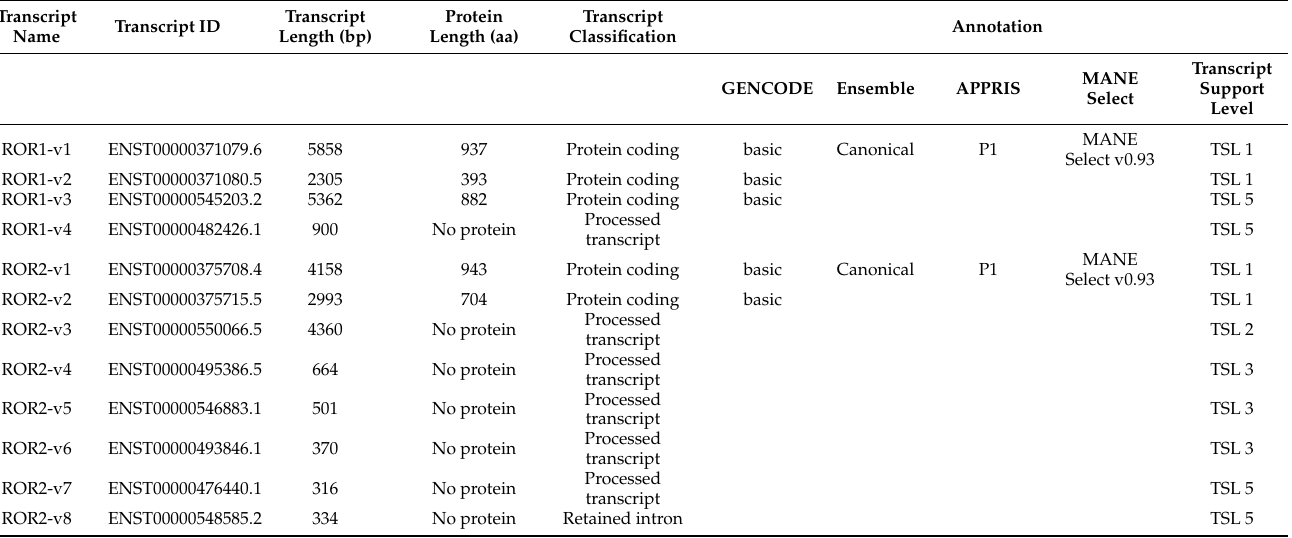
Table 1. Transcript variants of human ROR1 and ROR2 genes. Transcript variants annotated in the GRCh38 dataset from the Genome Reference Consortium were assessed on the Ensembl genome browser (release 104). TSL: transcript support level; TSL1: transcript variants supported by a minimum of one non-suspect mRNA for every splice junction; TSL2: transcript variants supported by multiple ESTs or where the strongest supporting mRNA is flagged as suspect; TSL3: transcript variants supported by a single EST; TSL4: best-supporting EST for the transcript variant is flagged as suspect; TSL5: transcript variants for which the structural model is not supported by a single transcript.